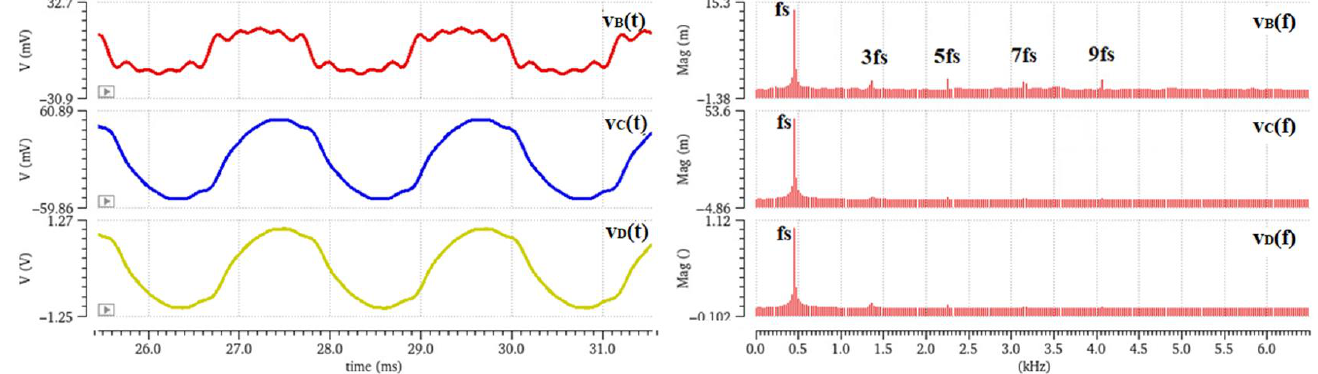
Figure 19. Transient and frequency analysis of the signals before/after filtering and after amplifica- Figure 19. tion — odd harmonics of the fundamental frequency are added to the raw sensor signal. amplification—odd harmonics of the fundamental frequency are added to the raw sensor signal.